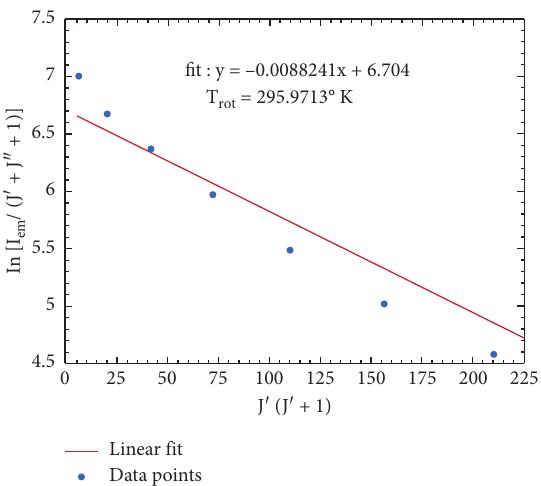
Figure 7: Determination of the rotational temperature of the CAPJ (5kV, 19.56 kHz, and